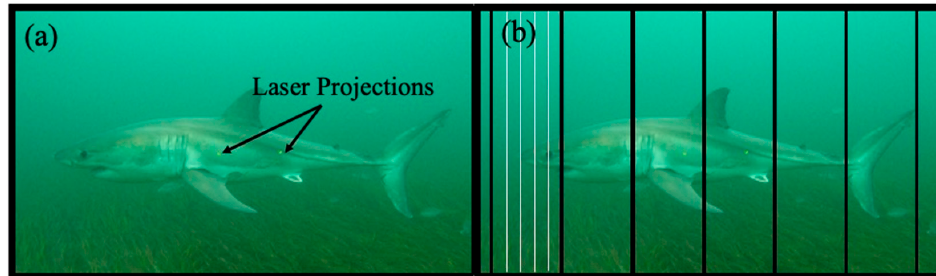
Figure 2. Laser photogrammetry image captured by the laser-equipped Blue Robotics Underwater remote operated vehicle (BlueROV2) of an early-stage juvenile white shark ( Carcharodon carcharias ) at Daw Island in March 2021. ( a ) The parallel laser projections can be seen on the flank of the shark. ( b ) This image was then rescaled to fit a measurement template (i.e., black vertical lines with each space representing 0.33 m and white vertical lines representing 6.6 cm) allowing the determination of this shark’s total length of 1.85 m.